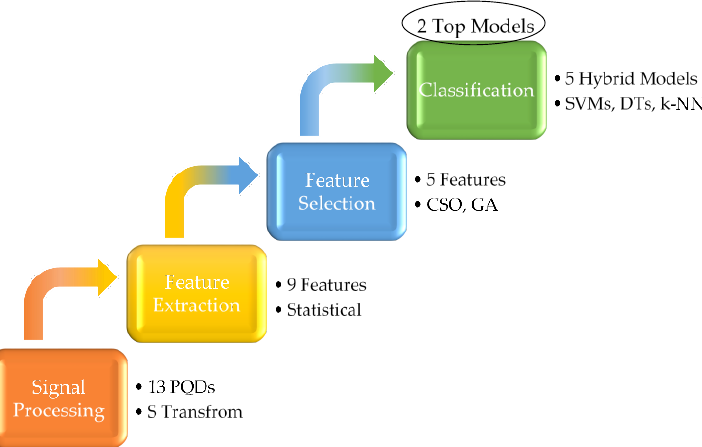
Figure 1. General block scheme of the proposed classification plan.